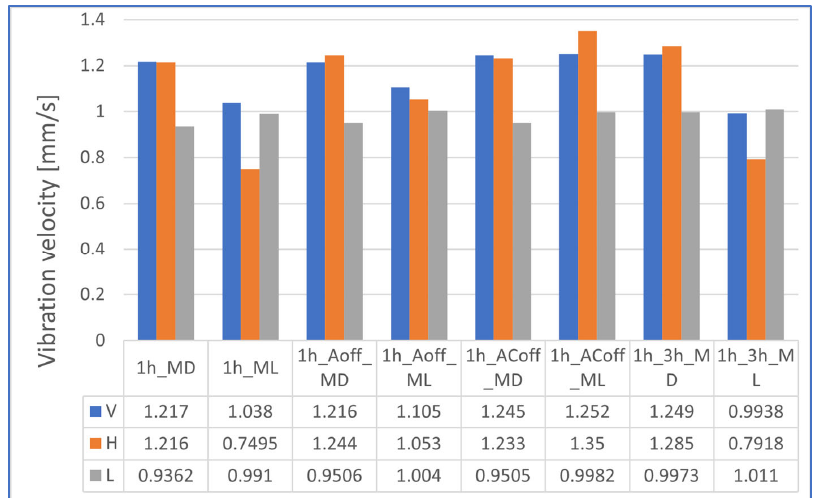
Figure 10. Vibration RMS distribution characteristics for a loaded motor and a rotational speed of 750 rpm.